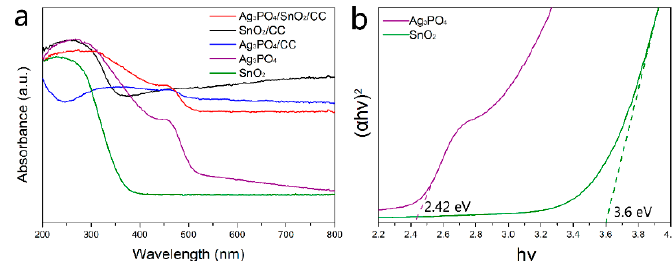
Figure 6. UV-vis diffuse reflectance spectra of the as-prepared samples ( a ). Plots of ( α h ν ) 2 versus energy (h ν ) of the as-prepared Ag 3 PO 4 and SnO 2 ( b ).